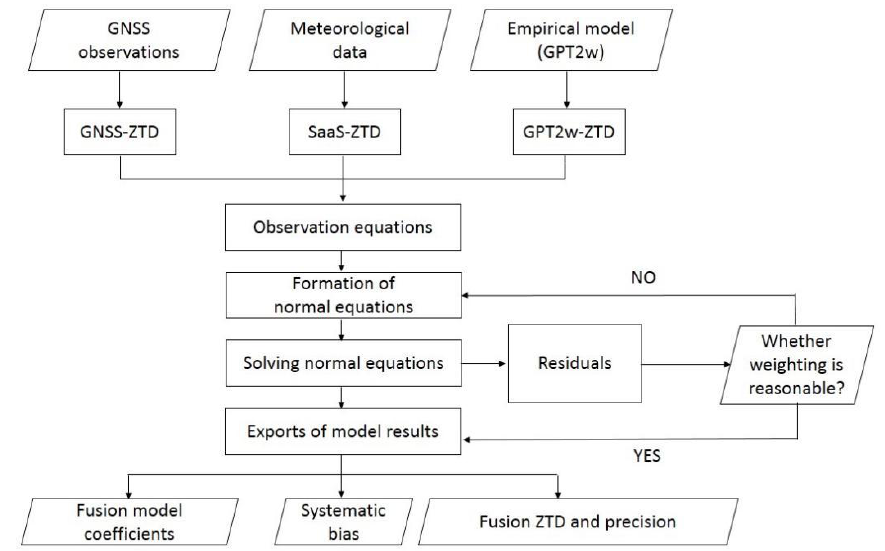
Figure 1. Flowchart of troposphere fusion modeling.